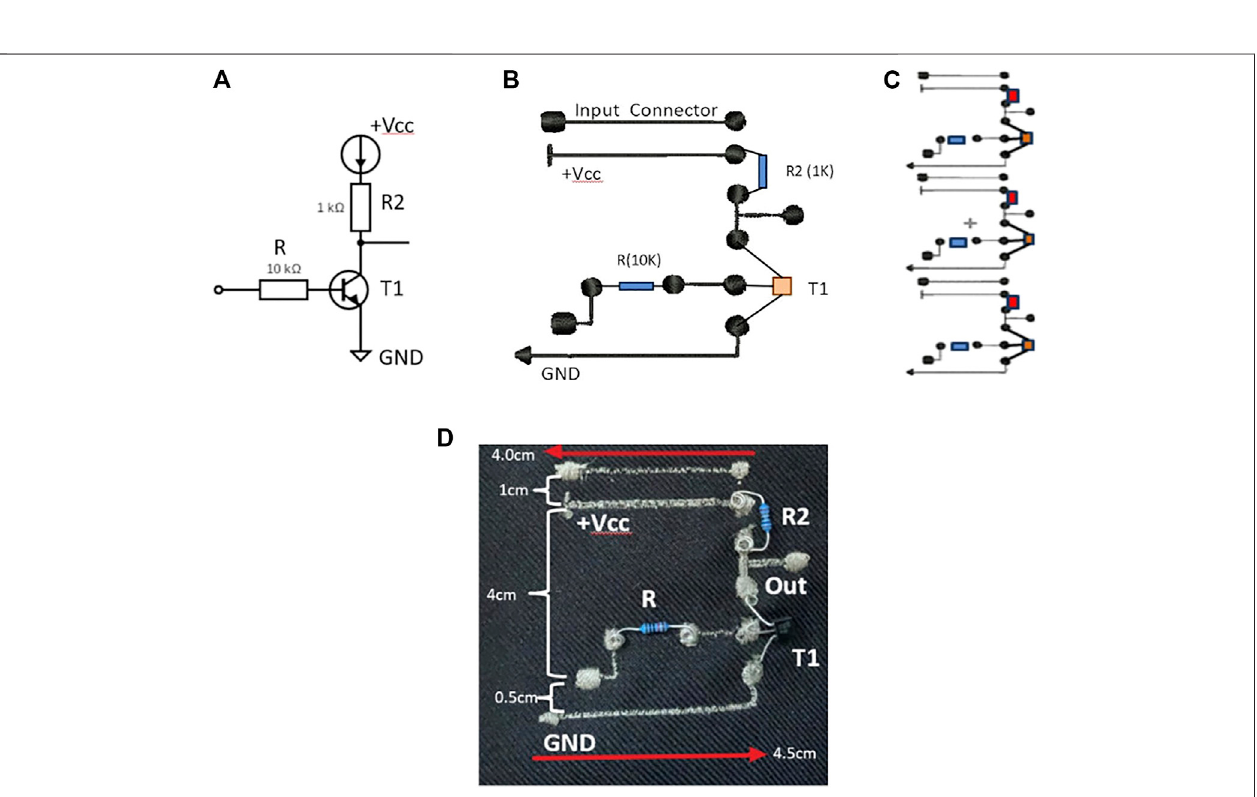
FIGURE 4 | Input/inverter logic gate: (A) 2-input inverter logic gate constructed using RTL resistor – transistor, (B) inverter logic gate embroidered digitized design layout, (C) cluster of inputs (A – C) in the layout design, and (D) embroidered logic inverter and input gate detailing circuit layout measurements.